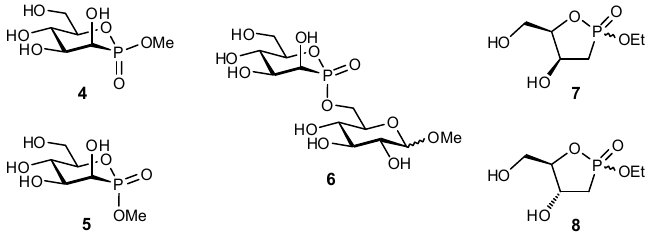
Figure 2. A series of phostone analogues have been evaluated as glycomimetics [80,81].